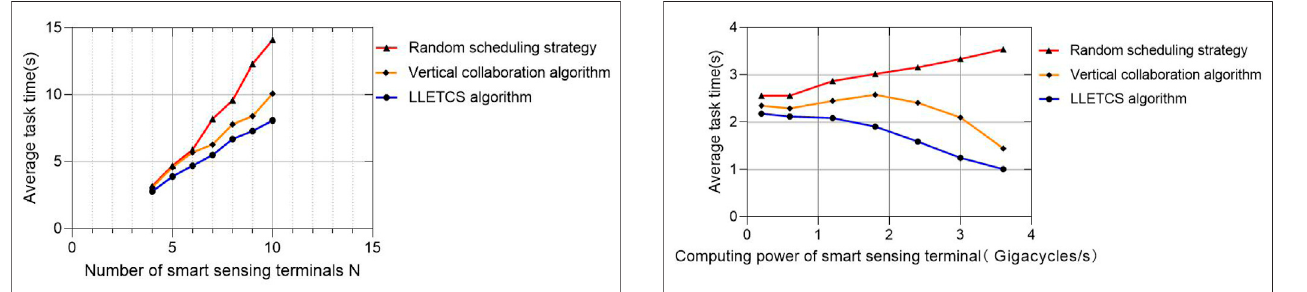
FIGURE 6 | Trend of increas in number of smart sensing terminals.